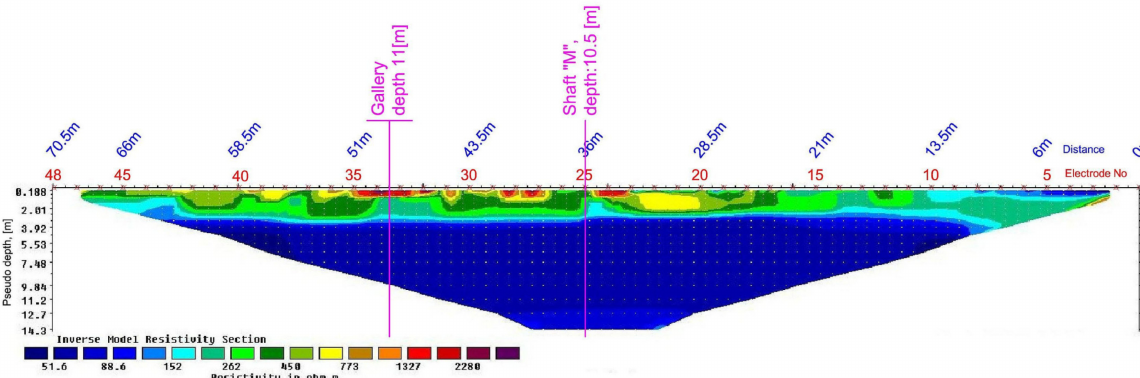
Figure 14. ERT profile obtained on the line with the Wenner–Schlumberger electrode